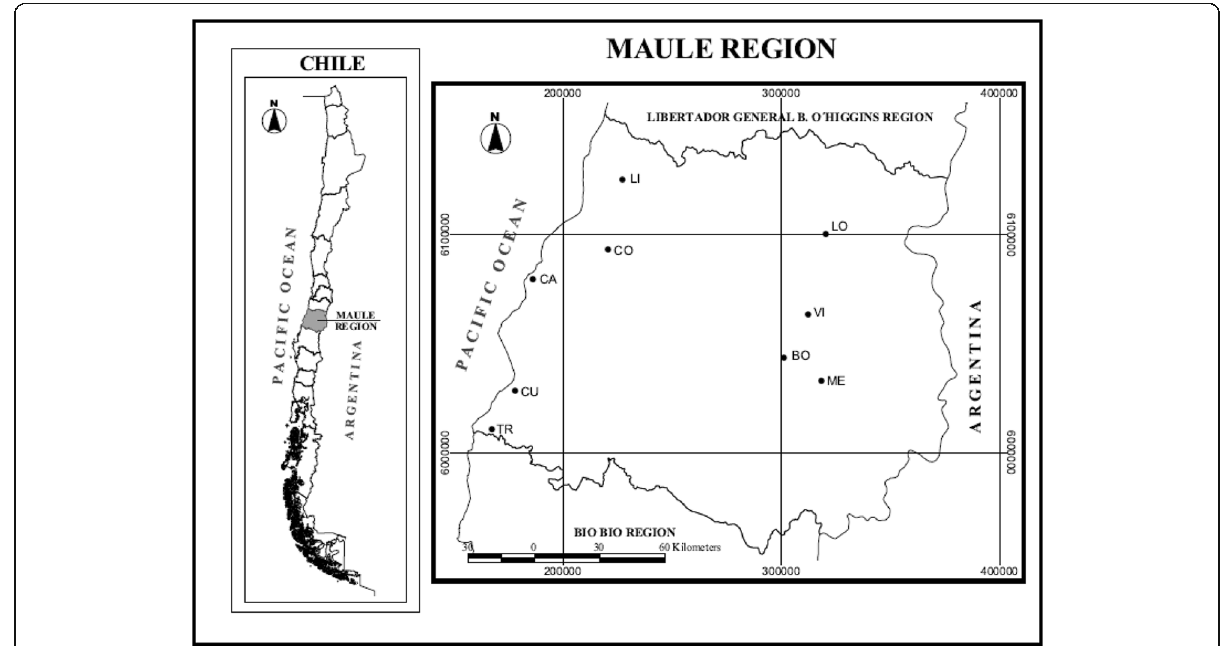
Fig. 1 Location of the Nothofagus glauca seed collection